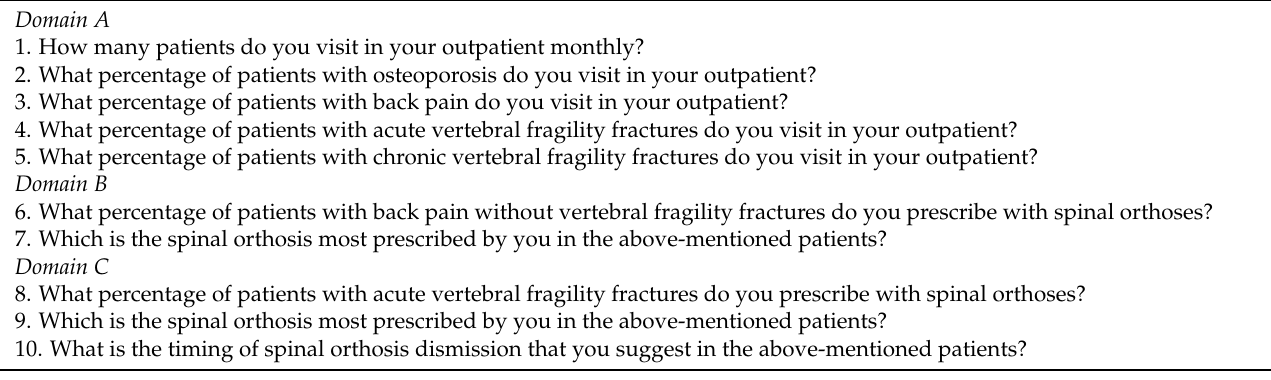
Table 1. A 13-item questionnaire aimed to investigate the clinical management of patients affected by vertebral fragility fractures referring to physiatric outpatient